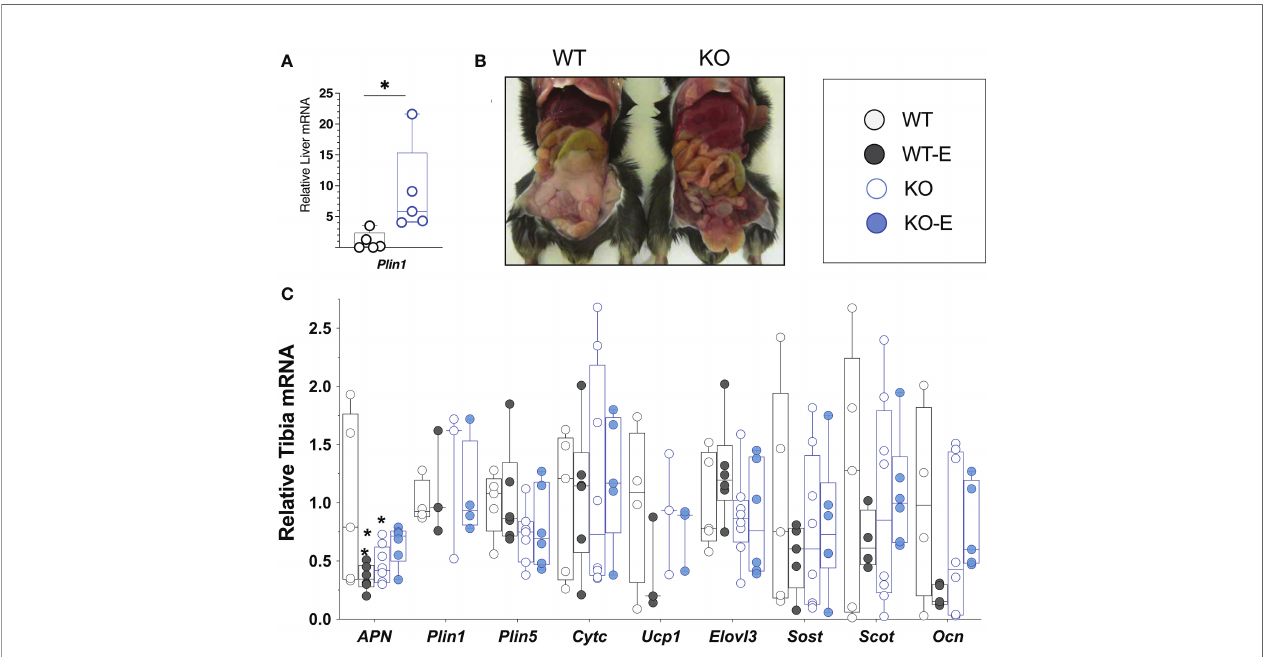
FIGURE 6 | SEIPIN global KO demonstrate higher liver Plin1 expression, consistent with lipodystrophy. (A) Liver mRNA (N=5) via qPCR shows relative expression of Plin1. (B) , Representative photo of KO and WT demonstrating lipodystrophic liver phenotype in KO. (C) Whole Tibia mRNA (N=4-8) via qPCR for metabolism, bone markers. Box and whisker plot, min to max with means. Between group differences as *p < 0.05 vs.